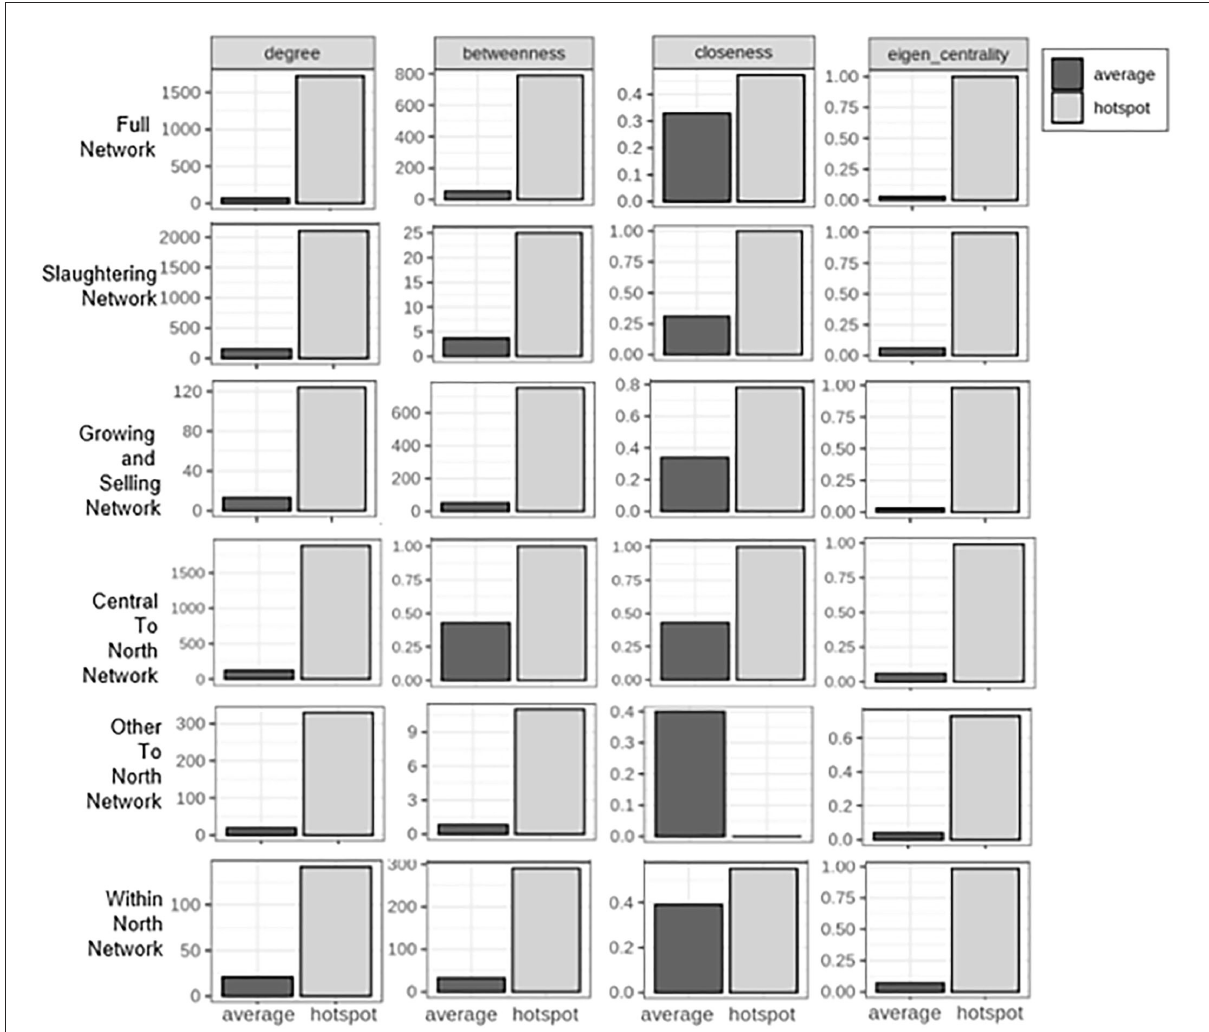
FIGURE2 Comparisons of network averages and influential hot spot district averages. This bar plot shows the comparison of means between each of the six networks (full network, slaughtering network, growing and selling network, central-to-north movement, other-to-north movement, and within-north movement). The x-axis represents the groups in comparison: network average or influential hot spot average. The y-axis represents the value of means. This panel contains six rows showing the network evaluated and four columns showing the network metric